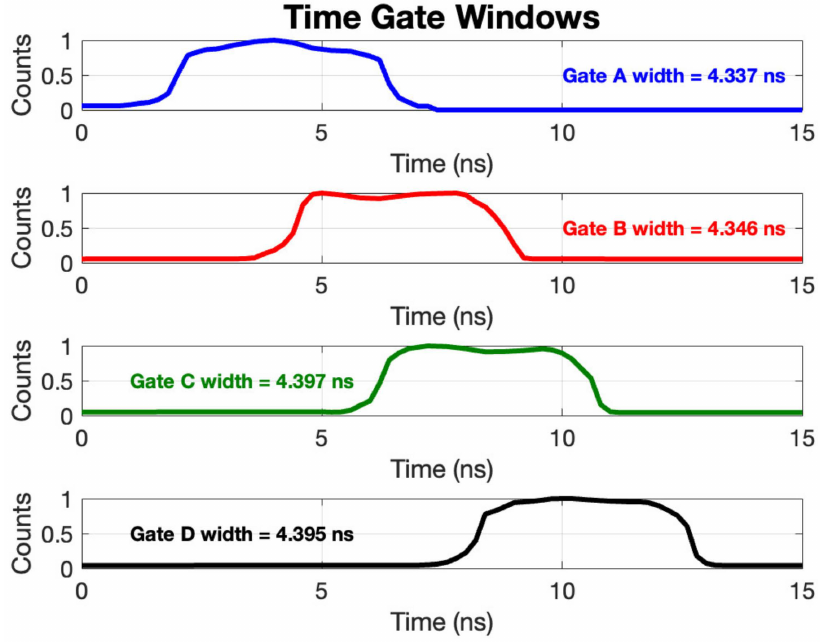
Figure 10. The measured time-gate windows for each SPAD